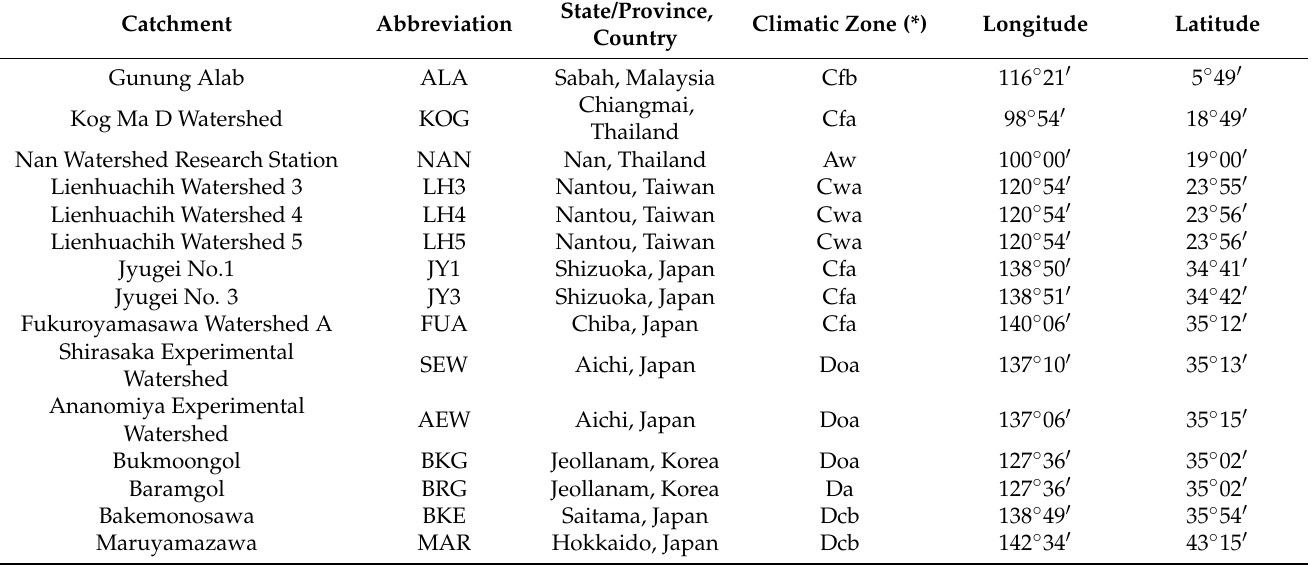
Table 1. Examined catchment information.